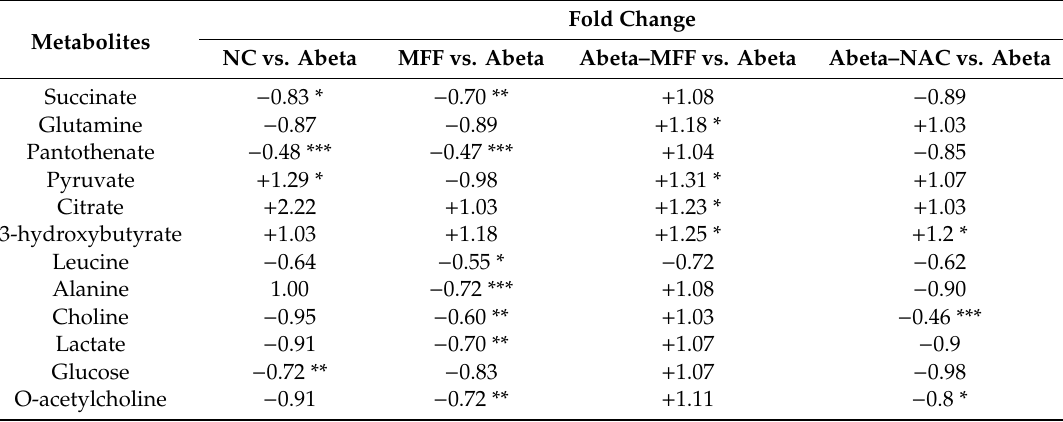
Table 1. Metabolite markers for the control and treated rats extracted from the OPLS-DA model. Those metabolites which had a variable importance of projections (VIP) > 0.7 and p < 0.05 are considered.